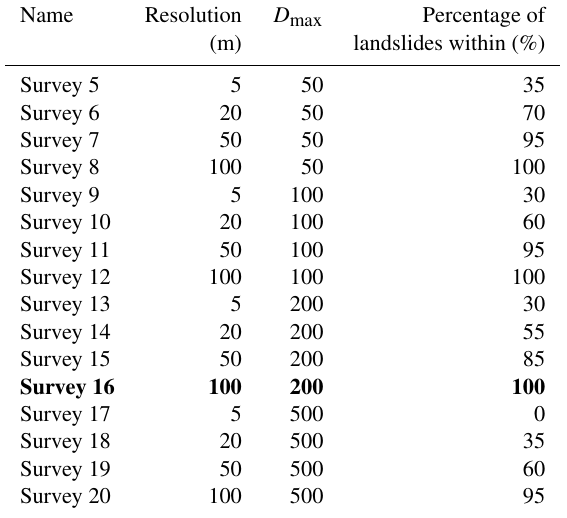
Table 1. Results of the setting test of r.survey in a 10km 2 subset of the study area. The best combination of settings is highlighted in